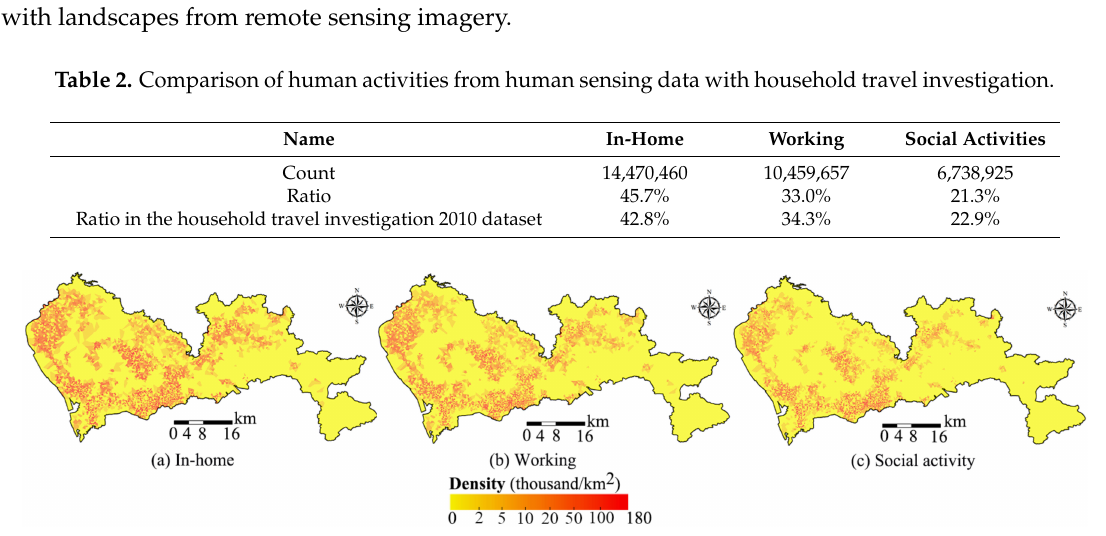
Figure 7. Human activity from mobile phone records. ( a ) Density of in-home; ( b ) density of working; ( c ) density of social